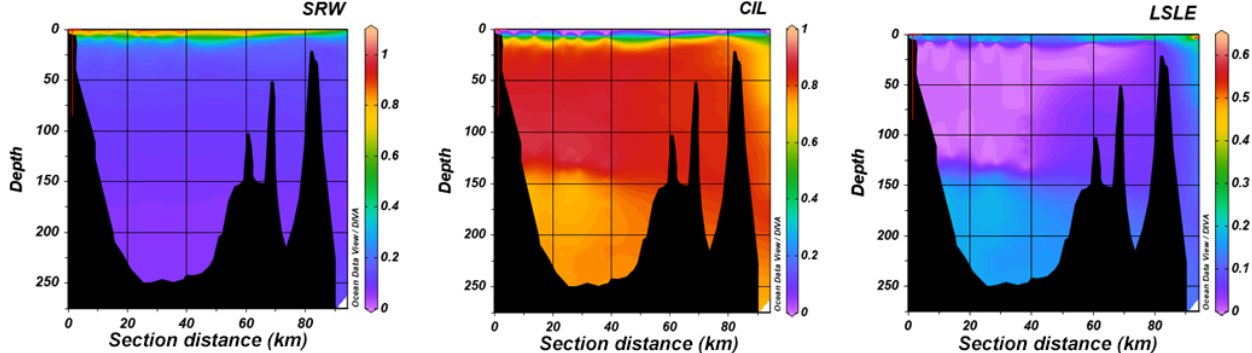
Figure 3. Vertical sections showing the relative contributions of the Saguenay River (SRW), the St. Lawrence Estuary cold intermediate layer (CIL) and Lower St. Lawrence Estuary bottom waters (LSLE) to the water column structure of the Saguenay Fjord (June 2017). Fractions were estimated using an optimum multiparameter (OMP) algorithm (Tomczak and Large, 1989; Tomczak, 1981; Mackas and Harrison, 1997). A variational analysis (DIVA) interpolation was applied between field data points in Ocean Data